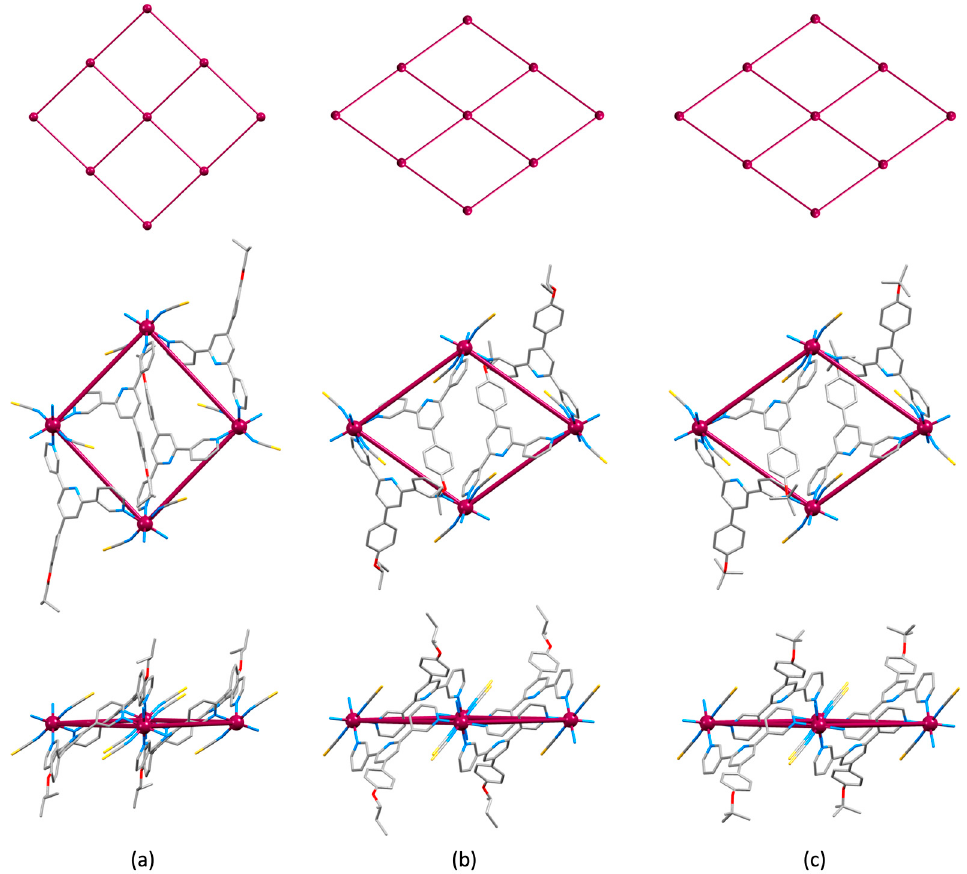
Figure 6. Comparison of the (4,4) nets in ( a ) [Co( 3 ) 2 (NCS) 2 ] n , ( b ) [{Co( rac - 2 ) 2 (NCS) 2 } · CHCl 3 ] n , and ( c ) [{Co( 4 ) 2 (NCS) 2 } · CHCl 3 ] n (top, middle and bottom diagrams for each compound). The Co...Co vectors are drawn to emphasize the (4,4) net. Table 3. Angles between the arene ring-planes in [{Co( rac - 2 ) 2 (NCS) 2 } · CHCl 3 ] n , [Co( 3 ) 2 (NCS) 2 ] n and